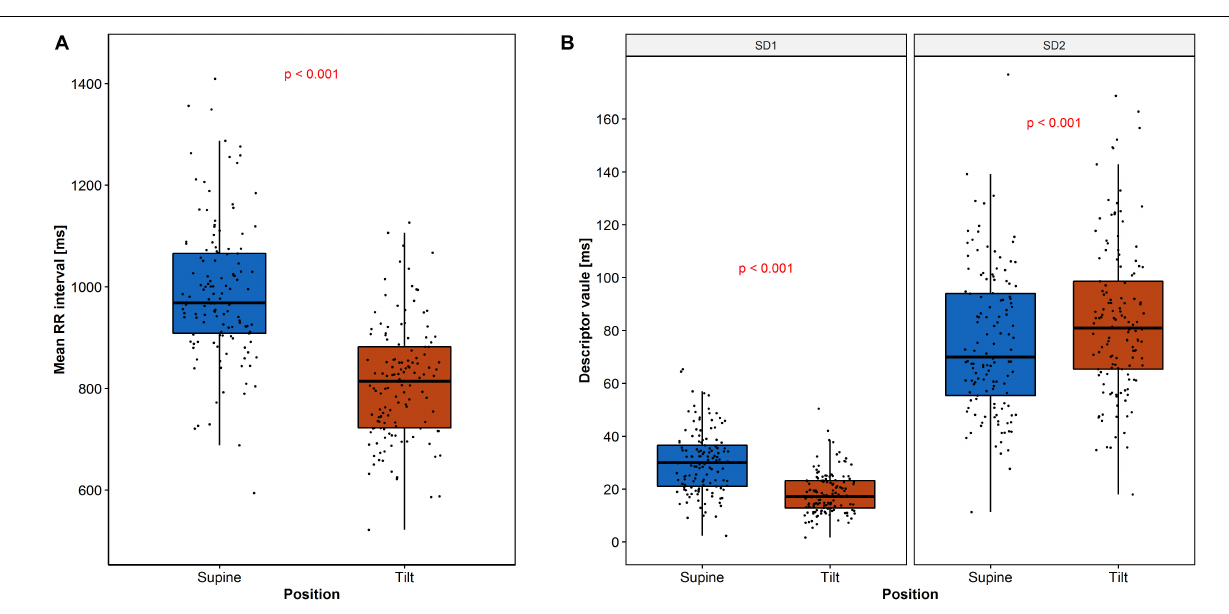
FIGURE 4 | Changes of RR intervals and HRV descriptors during HUTT: (A) mean RR intervals and (B) SD1 and SD2. The dots represent the